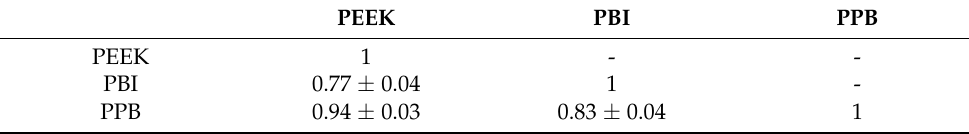
Table 1. Similarity index calculations based on FTIR spectra of the bulk materials.